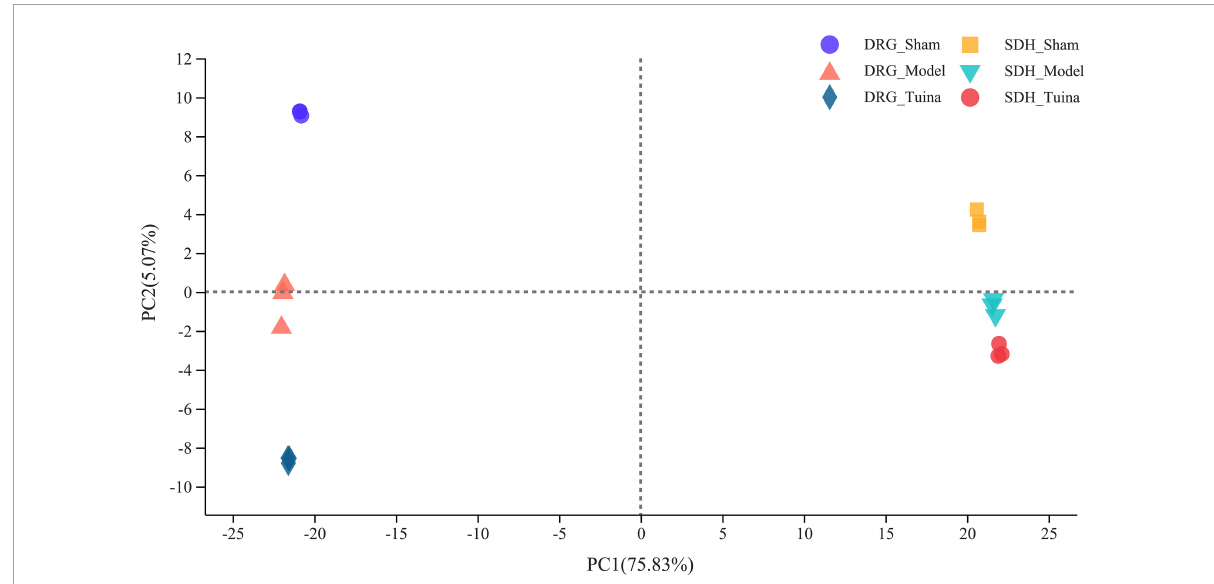
FIGURE3 PCA analysis of DRG and SDH samples. Sham group ( n = 3); model group ( n = 3); tuina group ( n = 3). PC1 = 75.83%, PC2 = 5.07%, a higher percentage means that this principal component is more capable of differentiating the samples. The distance between graphs represents how far the results of samples showed, and the farther distance indicates the lower similarity between